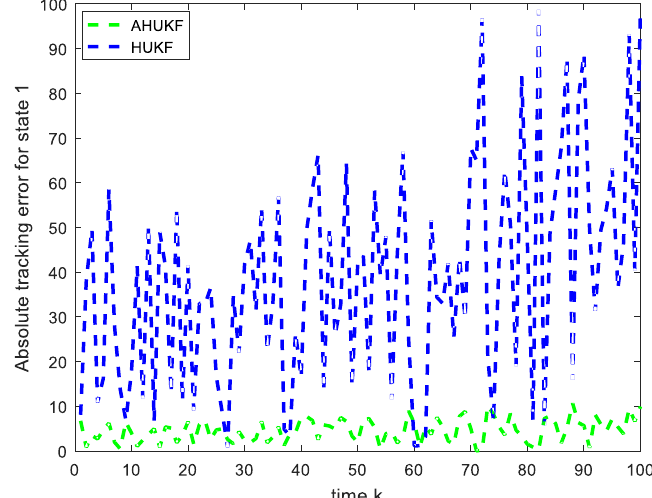
Figure 2. Tracking error curve for State 1.